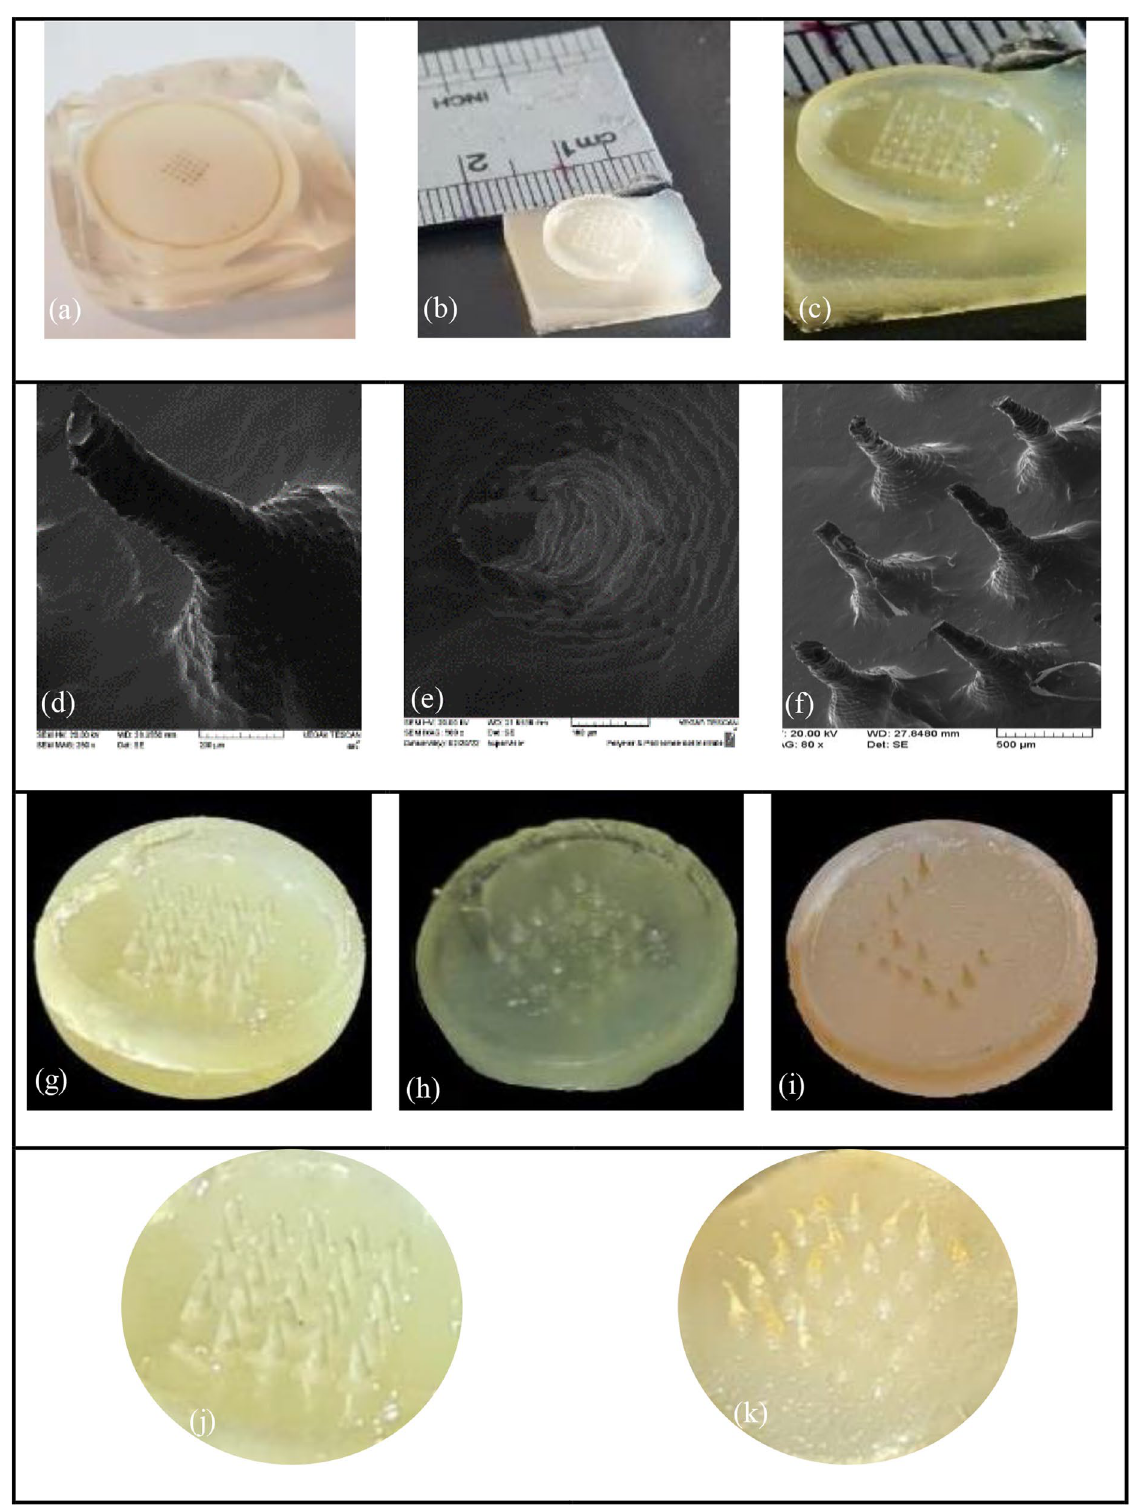
Fig. 5 LidoHCl DMNs. a Hydrogel-filled silicon mold. b and c Synthesized samples. d SEM at 280 10 min after exposure to pH 5.5. j Before and k after the force